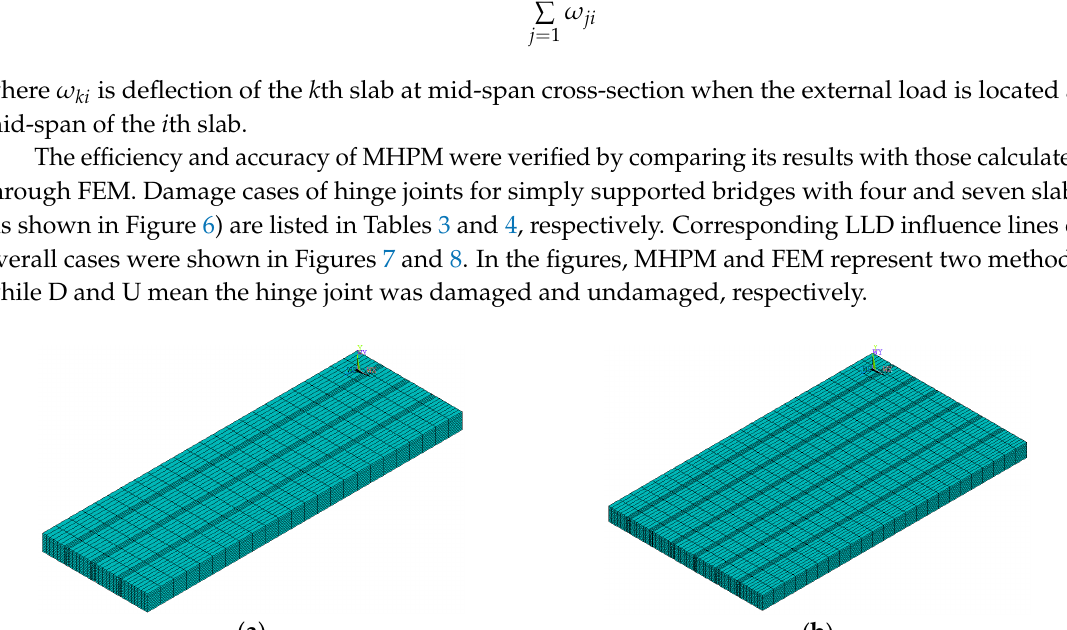
Figure 6. FEM of simply supported slab bridge: ( a ) composed of four slabs; ( b ) composed of seven